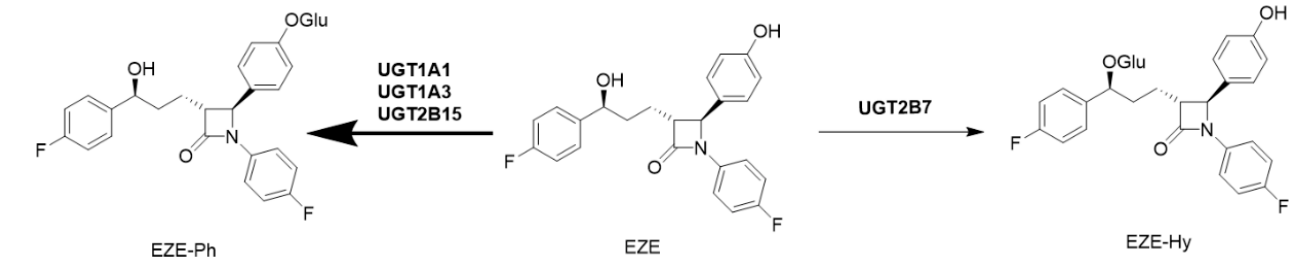
Figure 1. Major metabolic pathways of EZE in humans.